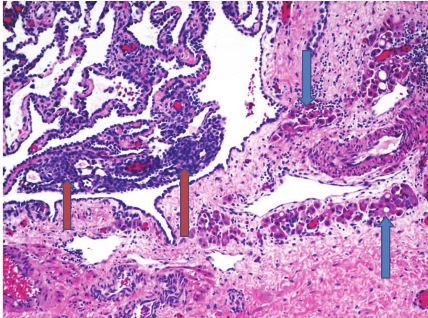
Figure 3: Another section of the tumor demonstrates sheets of Sertoli cells. Within the sheets of Sertoli cells, areas of small tubular formation can be seen. Clusters of Leydig cells are also noted (blue arrows) (H&E,